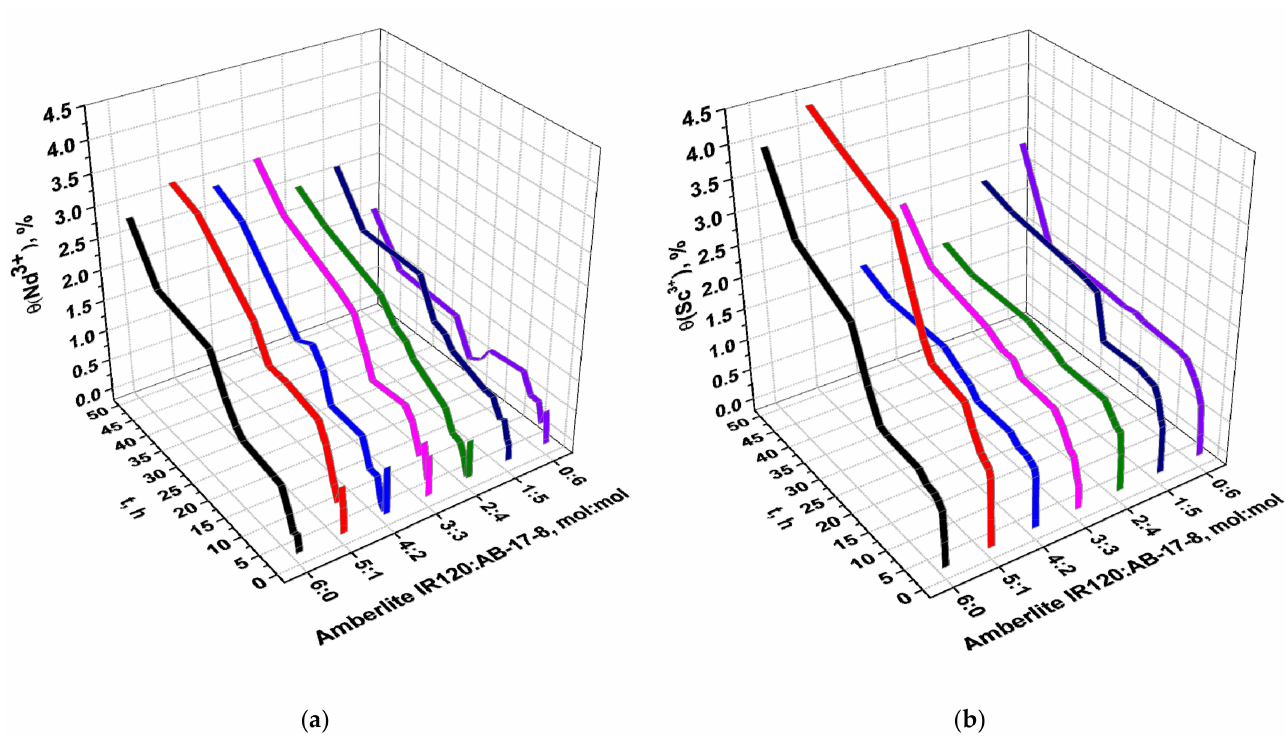
Figure 6. Polymer chain binding degree (in relation to Nd 3+ ( a ) and Sc 3+ ( b ) ions) of interpolymer system Amberlite